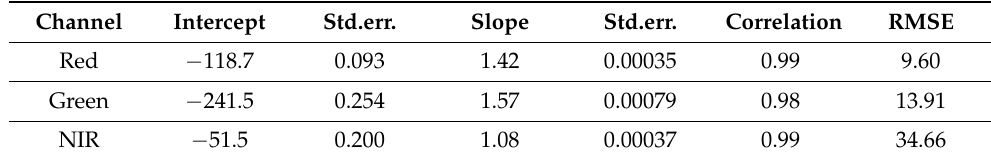
Table 1. Radiometric normalization parameters for the 2020 invariant pixels: interception, slope, and correlation. Values are digital numbers (DN). Channel Intercept Std.err.